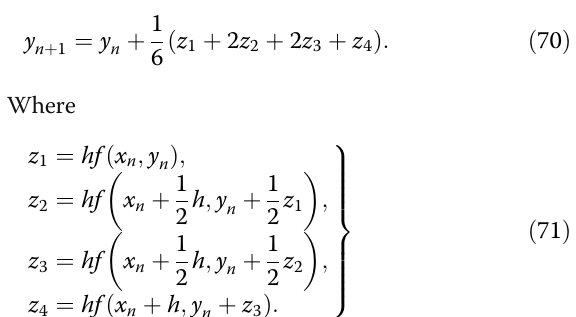
Table 1 The meanings of variables and parameters of the SEIR model (8) Symbols Meanings of Variables and Parameters Values Recruitment rate of